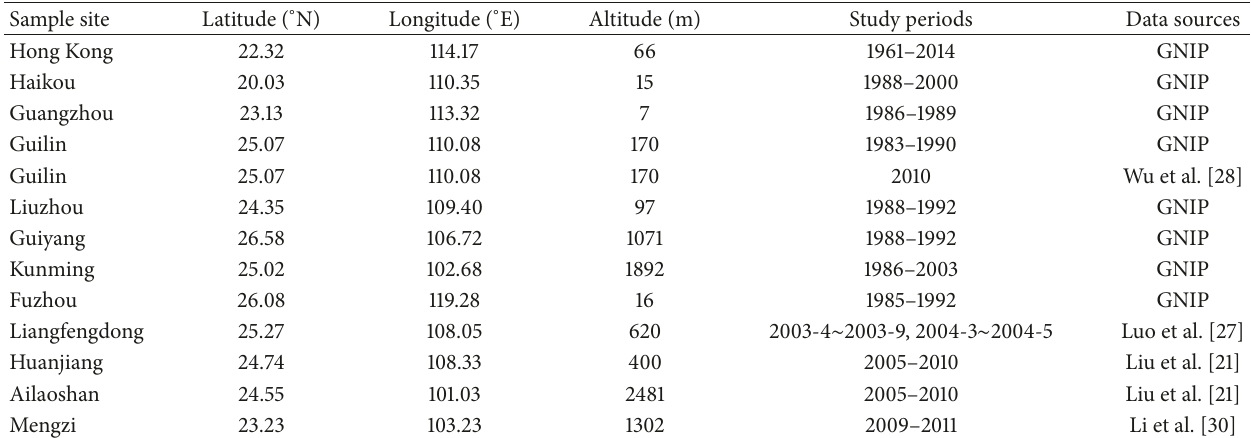
Table 1: Basic information of sampling